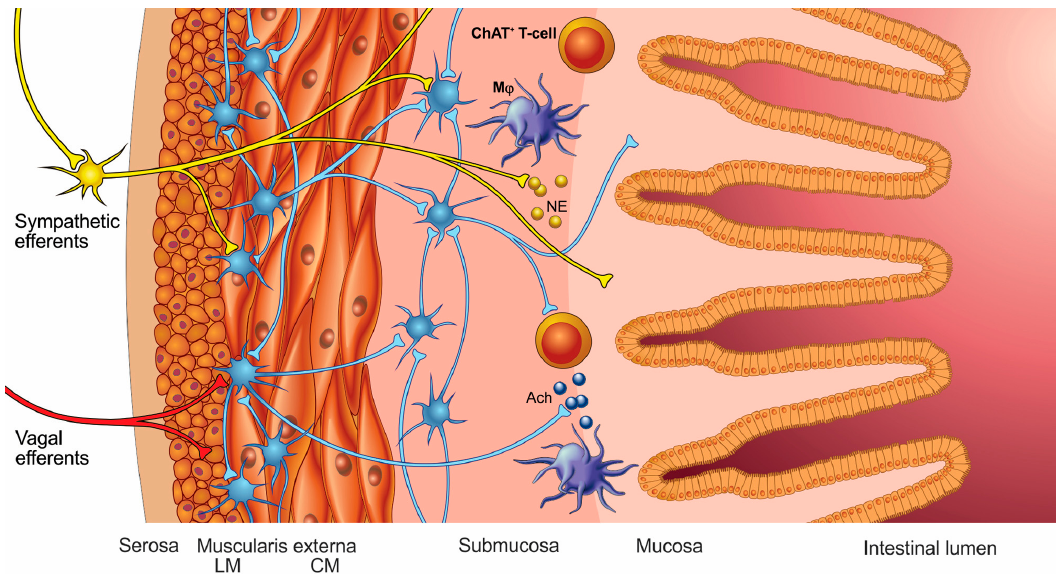
Figure 3. Innervation of the intestinal wall. Both sympathetic and cholinergic nerves innervate the intestinal wall, where they synapse with the enteric nervous system (ENS). Only the sympathetic nerve fibers reach the mucosal layer of the intestine, where they can interact with immune cells. The ChAT + T-cells reside in the intestinal wall, possibly contributing to immunological homeostasis. M ϕ —macrophages; NE—norepinephrine; ACh—acetylcholine.